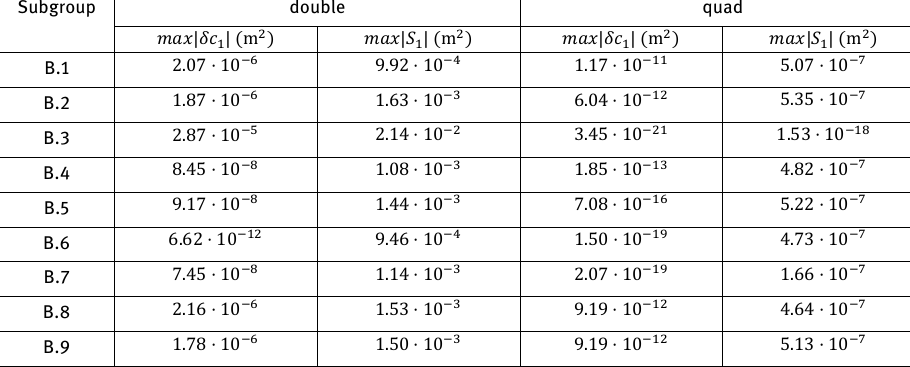
Table 11: Results in the Group B Subgroup